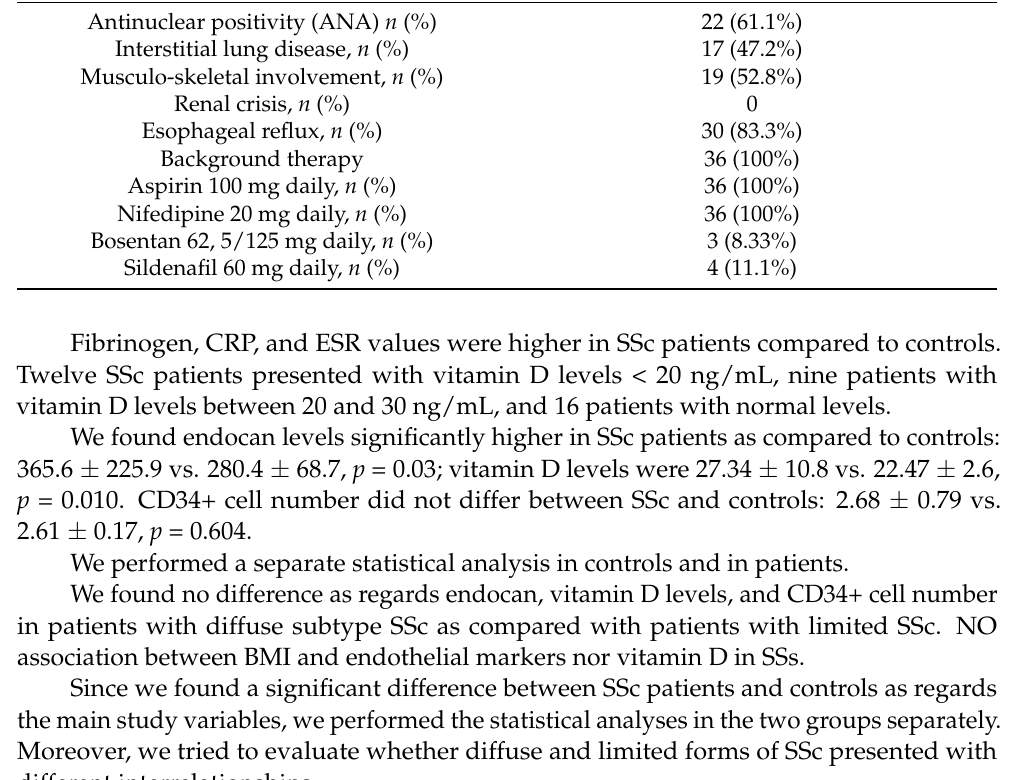
Table 2. Clinical characteristics of patients with systemic sclerosis. SSc Pattern of SSc, diffuse/limited (%) 24/12 (66.6/33.3%) Disease duration, month 78.3 ± 61.9 Anticentromere antibodies (ACA), n (%) 16 (44.4%) Anti-topoisomerase I (Anti-Scl70), n (%) 9 (25%) Antinuclear positivity (ANA) n (%) 22 (61.1%) Interstitial lung disease, n (%) 17 (47.2%) Musculo-skeletal involvement, n (%) 19 (52.8%) Renal crisis, n (%) 0 Esophageal reflux, n (%) 30 (83.3%) Background therapy 36 (100%) Aspirin 100 mg daily, n (%) 36 (100%) Nifedipine 20 mg daily, n (%) 36 (100%) Bosentan 62, 5/125 mg daily, n (%) 3 (8.33%) Sildenafil 60 mg daily, n (%) 4